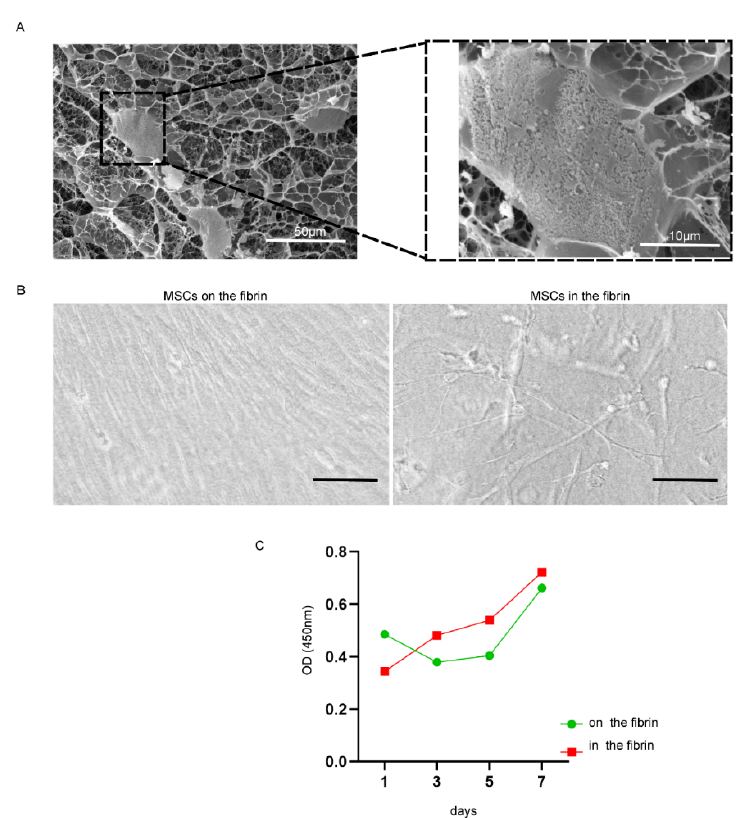
Figure 2. The status of growth and proliferation of UC-MSCs cultured with fibrin gel. ( A ) Frozen scanning electron micrographs. Right, magnified form of the cell indicated by black dotted bordered rectangle; magnification was 700 and 3000; scale bar, 50 and 10 μm. ( B ) Cells on (left) and inside (right) the fibrin gel were cultured and captured by light microscopy (scale bar, 100 μm). ( C ) The cell proliferation was detected by CCK-8; the red curve represented cells cultured inside the fibrin gel, and the green curve represented cells cultured on the fibrin gel.